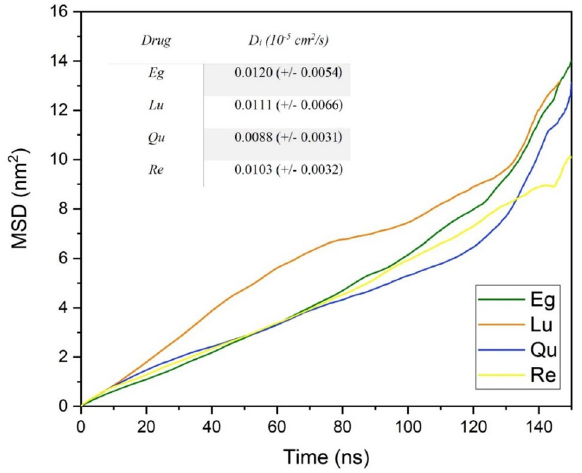
Figure 16. Mean square displacement of PP molecules in the investigated systems. Average diffusion coefficient